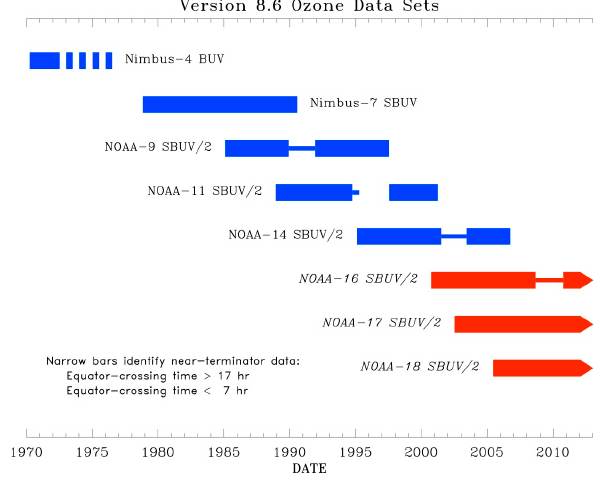
Fig. 1. Timeline of the datasets re-processed using Version 8.6 al- gorithm. The coverage of Nimbus-4 BUV was sparse in later years. Figure 1. Timeline of the datasets re-­‐processed using Version 8.6 algorithm. The Several NOAA instruments have missing data when the spacecraft coverage of Nimbus-­‐4 BUV was sparse in later years. Several NOAA instruments was in a near-terminator orbit. Instruments currently operating are have missing data when the spacecraft was in a near-­‐terminator orbit. Instruments shown in currently operating are shown in red.